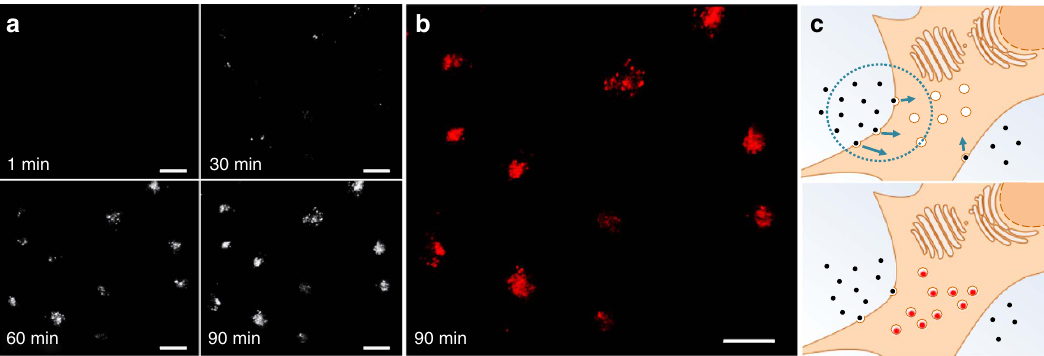
Figure 8 | Widefield live-cell imaging of the uptake of 2 (10 l M) into HeLa Kyoto cells. ( a ) Time-lapse black and white images are shown 1, 30, 60 and 90min. ( b ) Red-coloured image at 90min. ( c ) Schematic depiction of the uptake process of responsive fluorophore ( c ). Scale bars, 20nm.